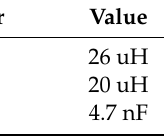
Table 2. Specifications of the designed LCL filter network for the PCS.